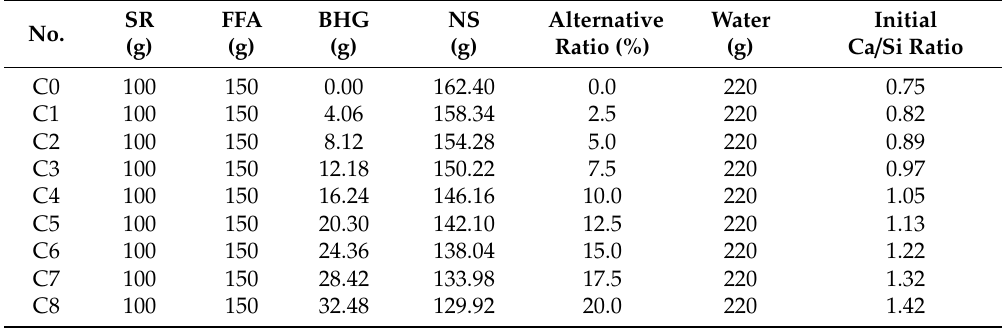
Table 5. Mass mixing proportions of backfill paste activated by beta-hemihydrate gypsum (BHG) alternative to partial sodium silicate